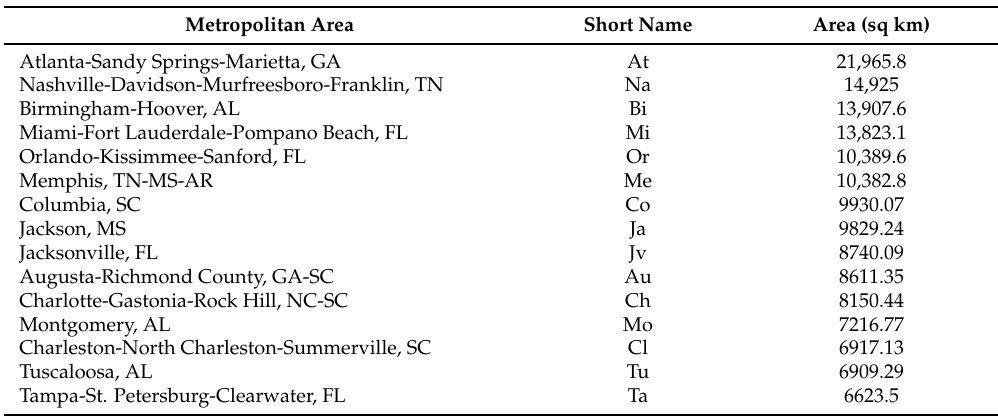
Figure 1. Land cover in the Southeast U.S.A. derived from the 2011 NLCD data set (30 m). The boundaries of the 15 largest metropolitan areas are imposed. AL = Alabama; FL = Florida; GA = Georgia; MS = Mississippi; NC = North Carolina; SC = South Carolina; TN = Tennessee. Table 1. The 15 largest metropolitan areas in the Southeast U.S.A.